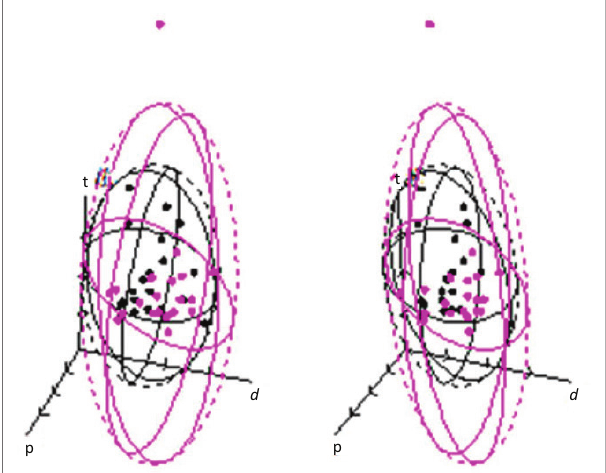
Note: The black points represent test measurements and the magenta points represent the corresponding retest measurements for 20 right eyes of adults aged 19–24 years. The axis lengths are 0.01 u ’ v ’ and the origin is at 0 u ’ v ’ units. Protan, deutan and tritan coordinate axes are indicated with labels p , d and t . FIGURE 4: Stereo-pair scatter plots with 95 % distribution ellipsoids for the Cambridge Colour Test - Trivector test and retest